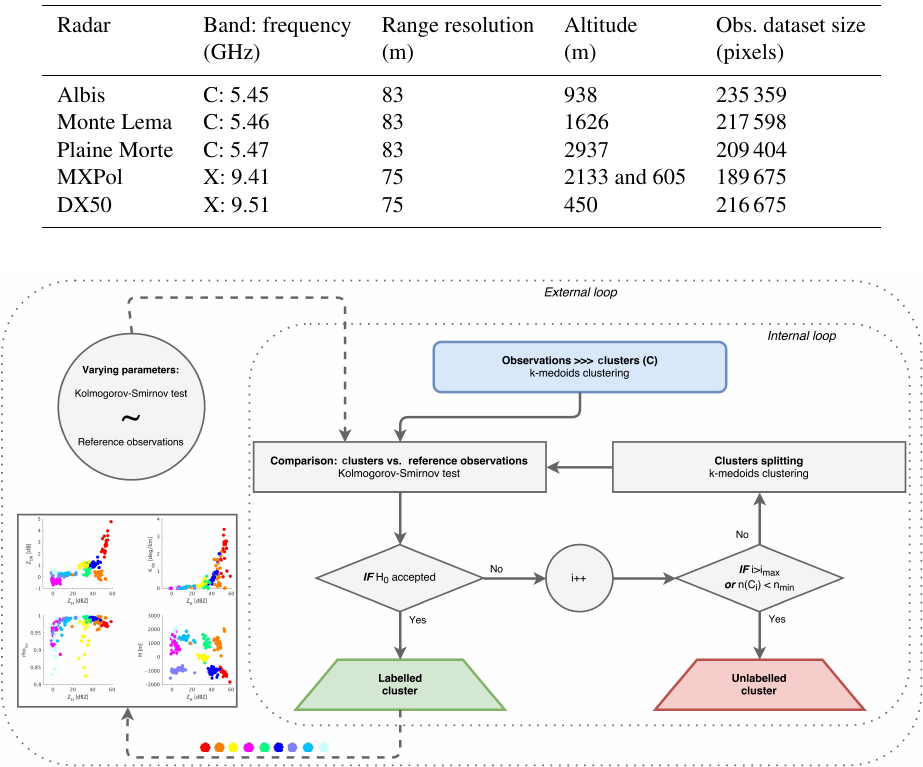
Figure 3. The schematic representation of the centroids derivation